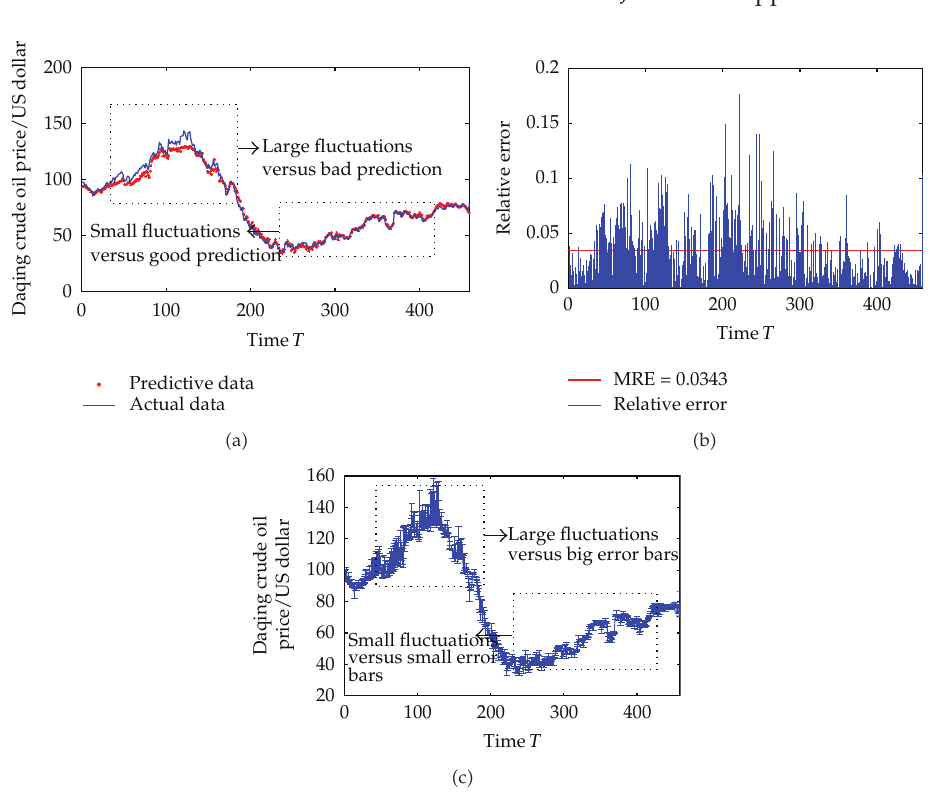
Figure 6: Comparisons of the fluctuation and the prediction of